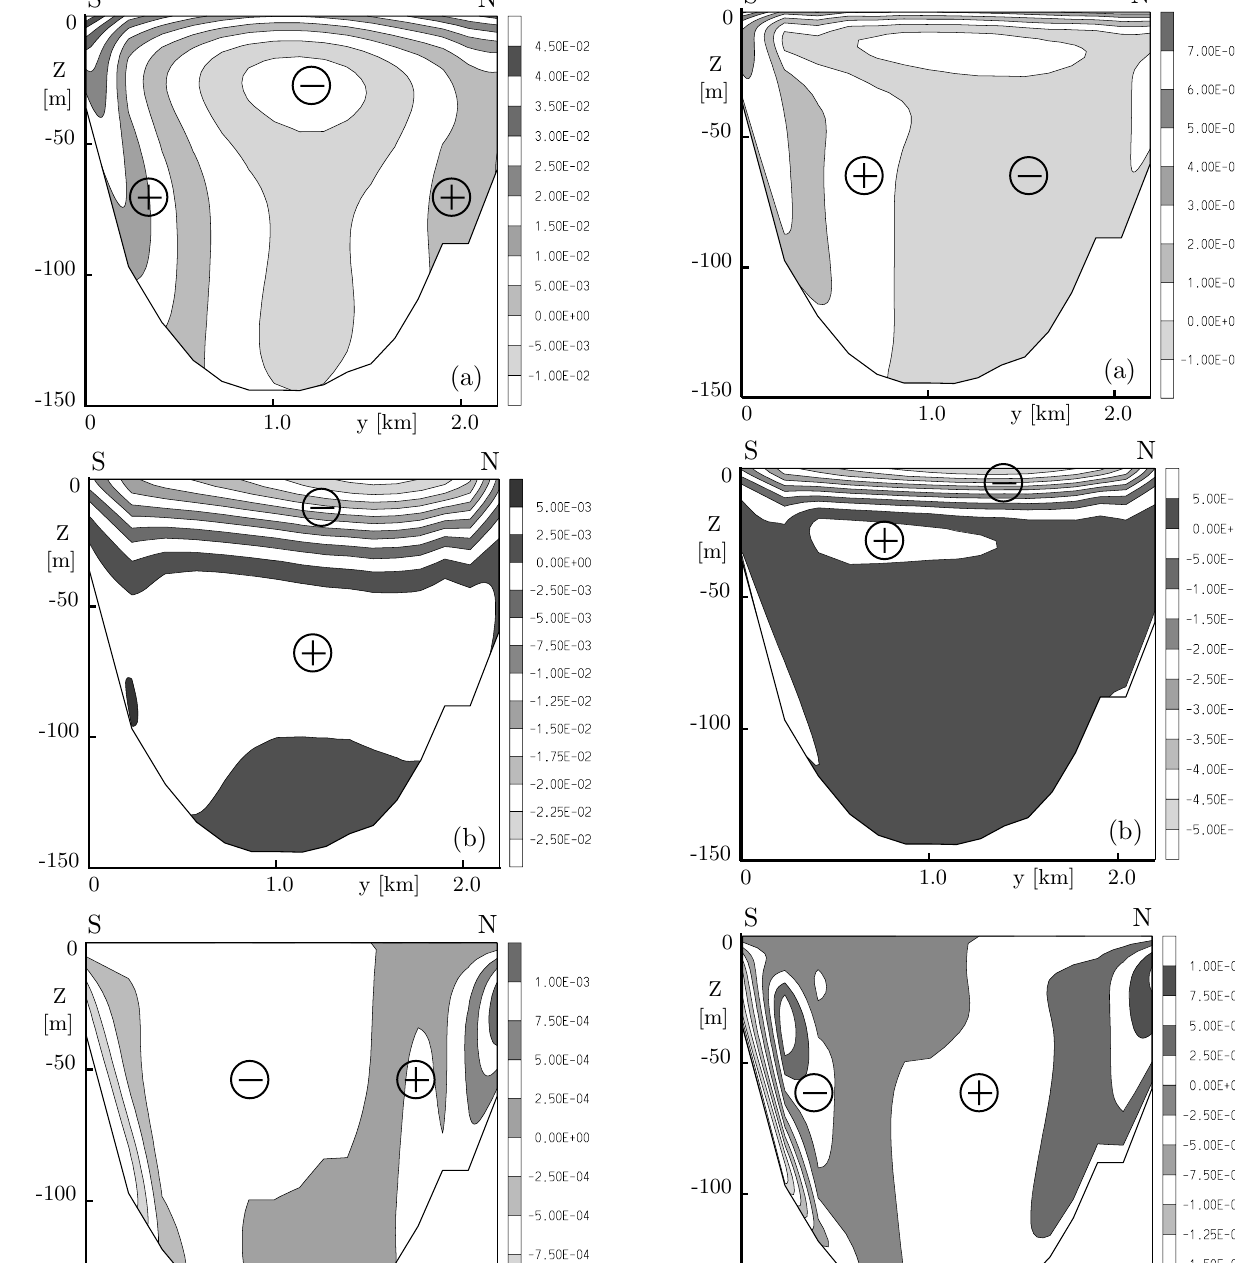
FIG. 16: Isotachs of the two horizontal and ver- tical velocity components u (a), v (b) and w (c) in a cross-section of the middle of the ¨ Uberlinger See in steady state subject to constant wind from 305 ◦ NW approximately in the longitudinal direc- tion (out of the page) with the vertical eddy viscos-